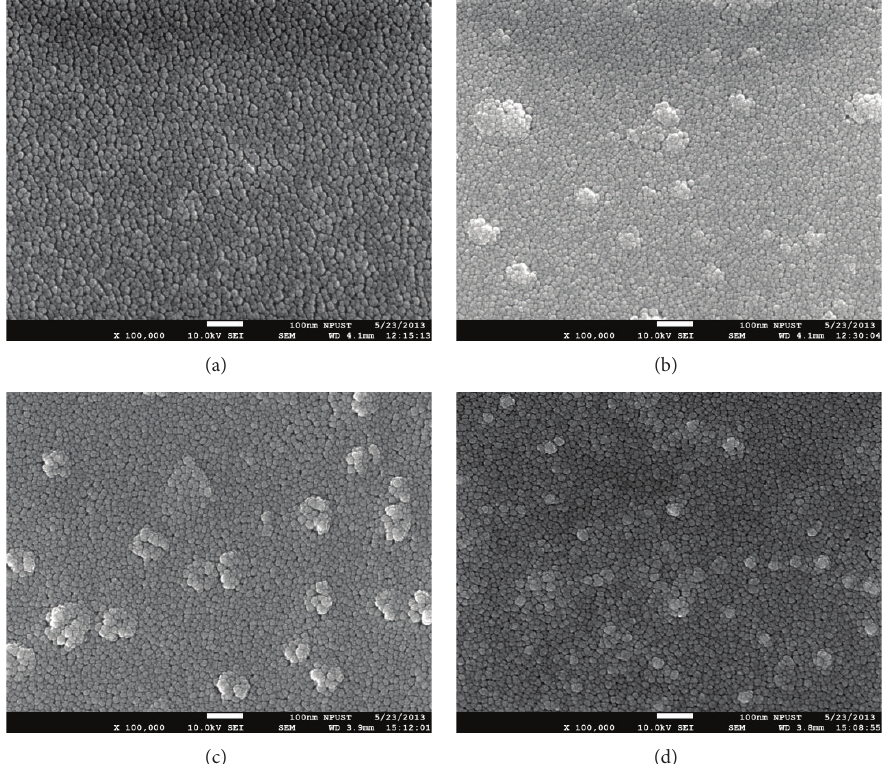
Figure 4: SEM micrographs of Ni-Cr-Si-Al-Ta films sputtered and annealed at (a) 200 W/300 ∘ C, (b) 200 W/400 ∘ C, (c) 200 W/500 ∘ C, and (d) 100W/500 ∘